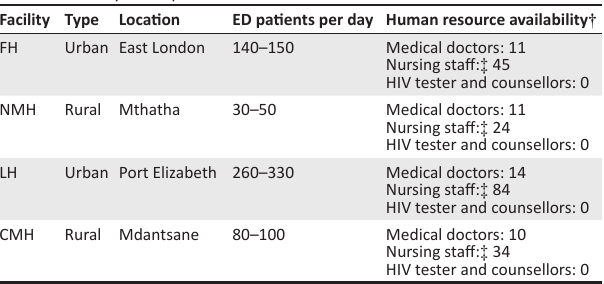
TABLE 2: Facility descriptions.